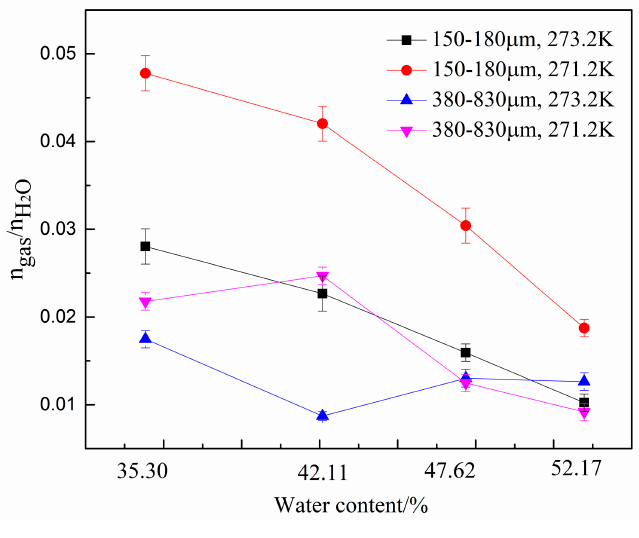
Figure 3. Gas consumption per unit mole of water ( n gas / n H conditions.